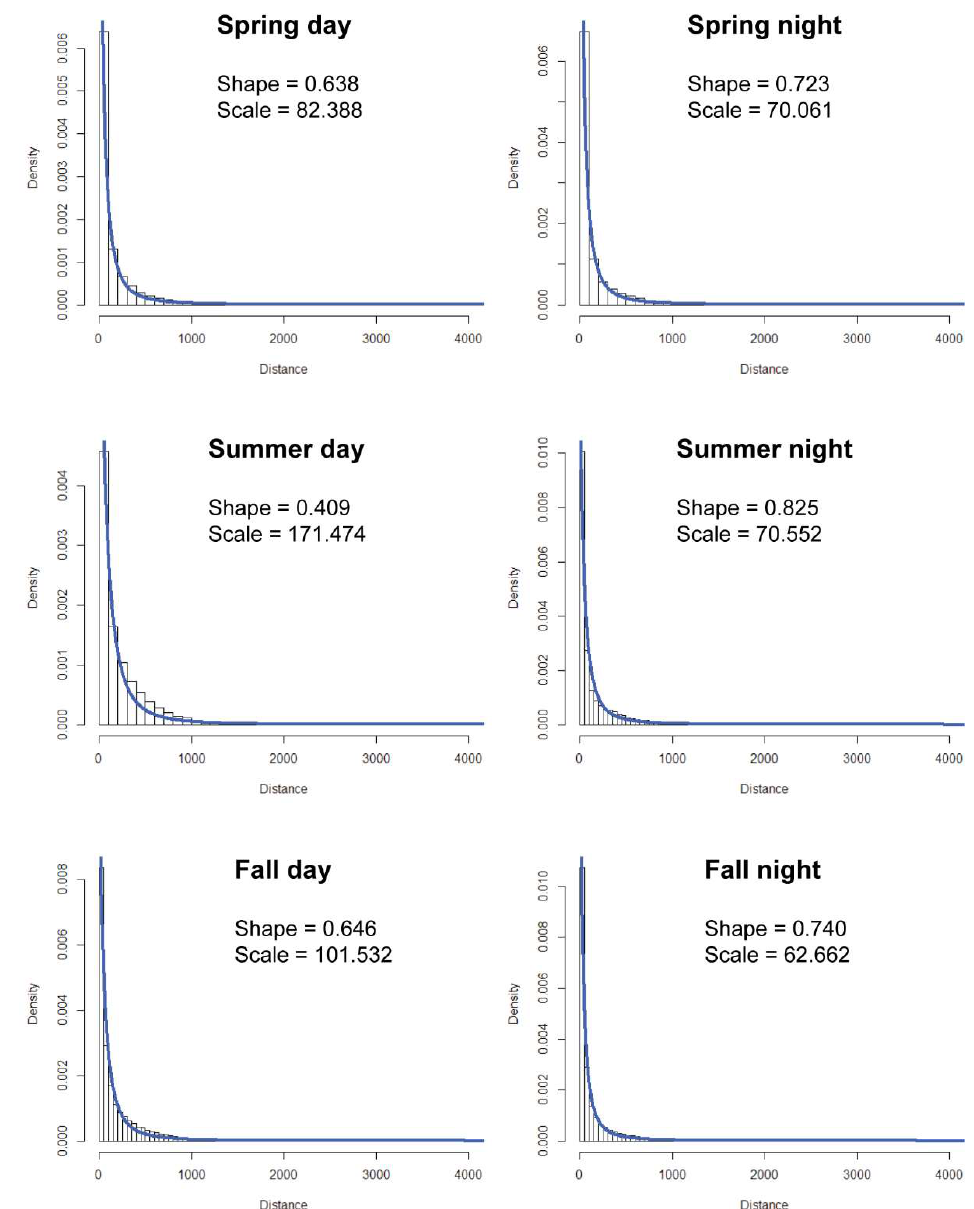
Figure A2. Histograms of empirical black bear step lengths with fitted Pareto distribution and parameters for each season / diel period. The shape of the Pareto distribution determines the shape of the tail of the distribution and the scale the spread.